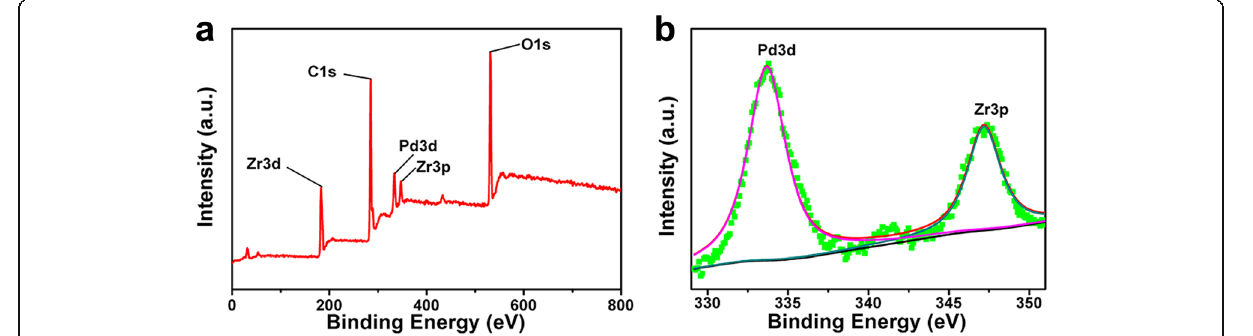
Fig. 6 a , b X-ray photoelectron spectroscopy (XPS) patterns of Pd/MOF 3%